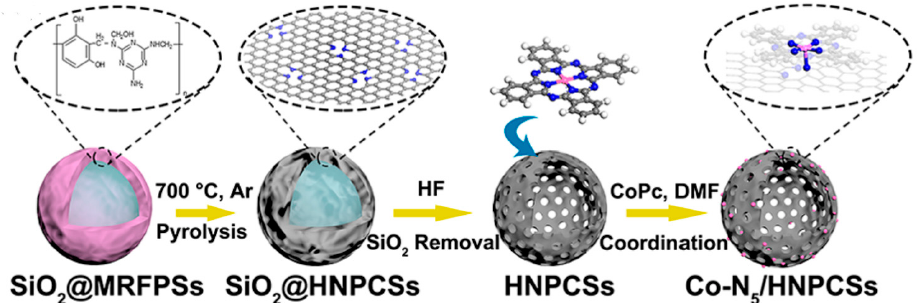
Figure 6. Schematic illustration of catalyst preparation. The core@shell SiO 2 @melamine-resorcinol- formaldehyde polymer spheres (MRFPSs) were first synthesized. Then, SiO 2 @N-doped porous carbon spheres were obtained by pyrolysis of SiO 2 @MRFPSs at 700 ◦ C under Ar. After etching the silica core with HF, the HNPCSs were obtained. Finally, the Co − N 5 /HNPCSs catalyst was prepared through constructing coordination interaction between Co and N. (Reprinted with permission from Ref. [33]. Copyright 2018 American Chemical Society).